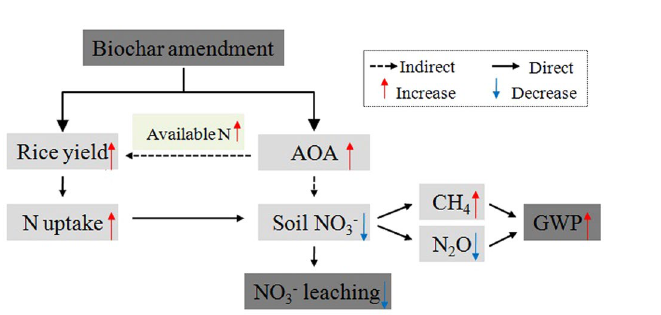
Table 4. Correlation coefficients (R 2 ) for the relationships among soil CH 4 and N 2 O fluxes, soil ammonia- oxidizers, soil NO 3 − -N and NH 4 + -N concentrations. Note: Significance: * P < 0.05; ** P < 0.01. For all correlations, n = 12. ( + ), positive relationship; ( − ), negative relationship.